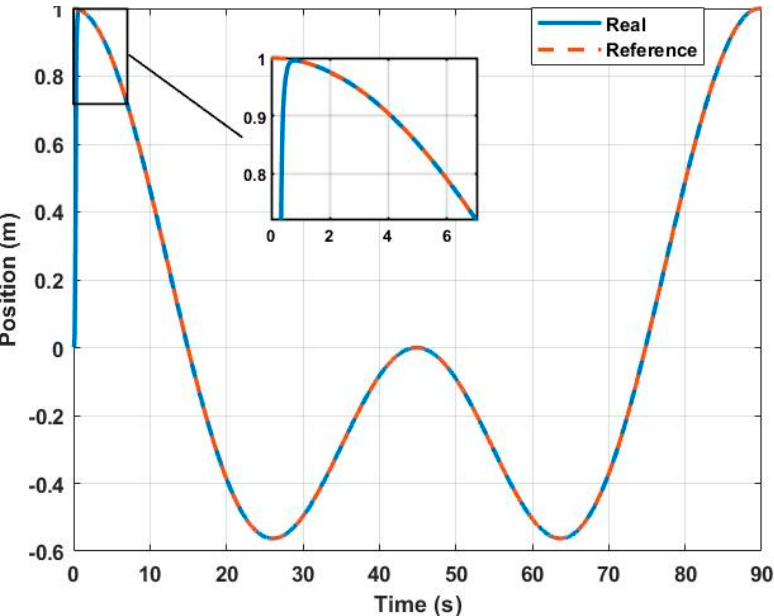
Figure 9. 𝑋 real ( 𝐵𝑙𝑢𝑒 𝑆𝑜𝑙𝑖𝑑 𝑙𝑖𝑛𝑒 ) vs. 𝑋 ( 𝑅𝑒𝑑 𝑑𝑜𝑡𝑡𝑒𝑑 𝑙𝑖𝑛𝑒 ) desired.